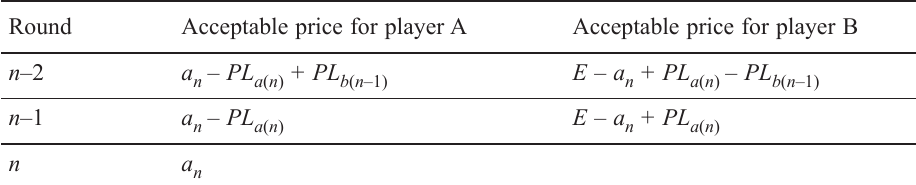
Table 1. The acceptable prices in the last three rounds Round Acceptable price for player A Acceptable price for player